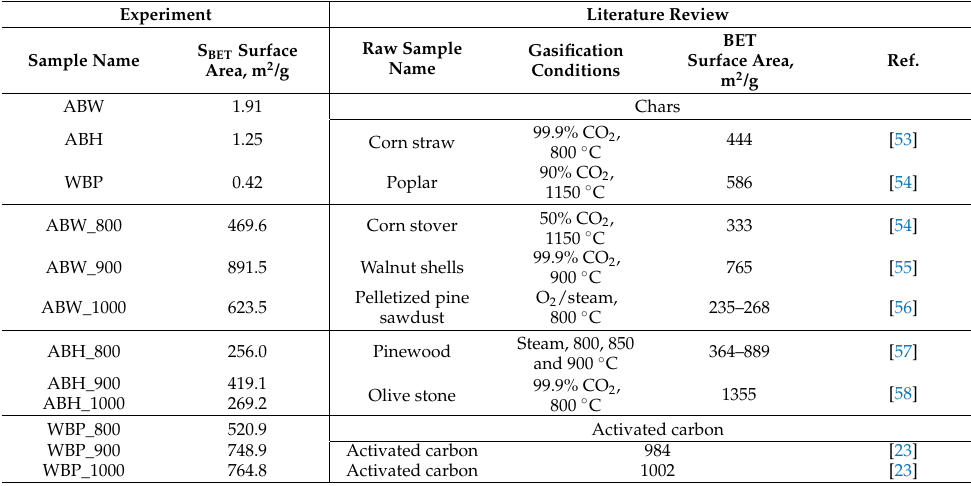
Table 5. BET analysis of raw biomass and